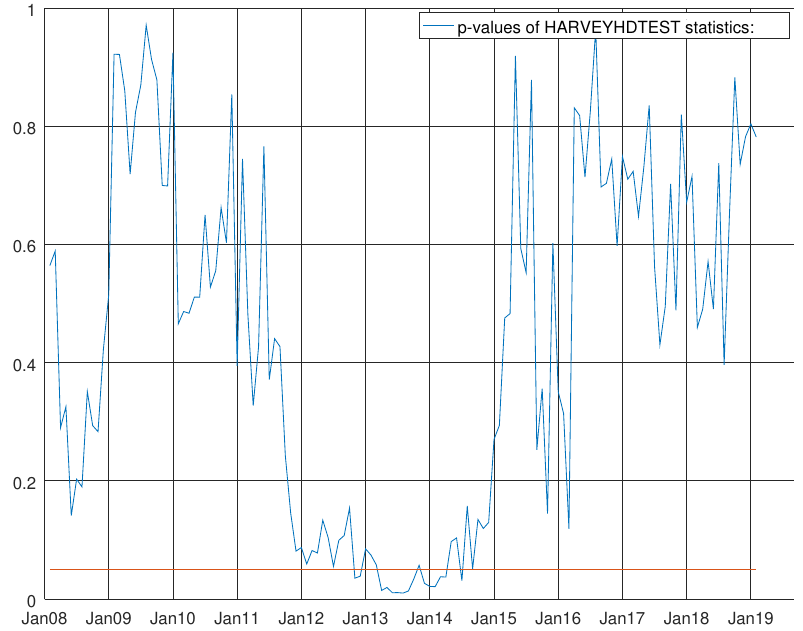
Figure 6. Graph showing the p -values of the Durbin–Watson test for the VARMA model using the hard data only. The null hypothesis states that residuals are not autocorrelated.